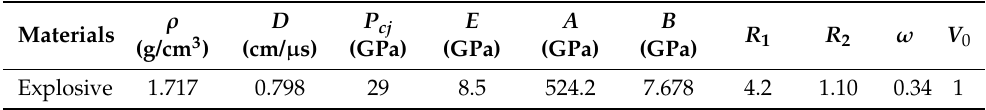
Table 3. Material parameters for the Comp-B explosive.